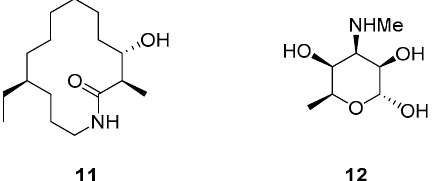
Figure 2. 6-Desmethyl-fluvirucinine A 1 ( 11 ) and the carbohydrate part ( 12 ) of 6-desmethyl- N - methylfluvirucin A 1 ( 8 ).